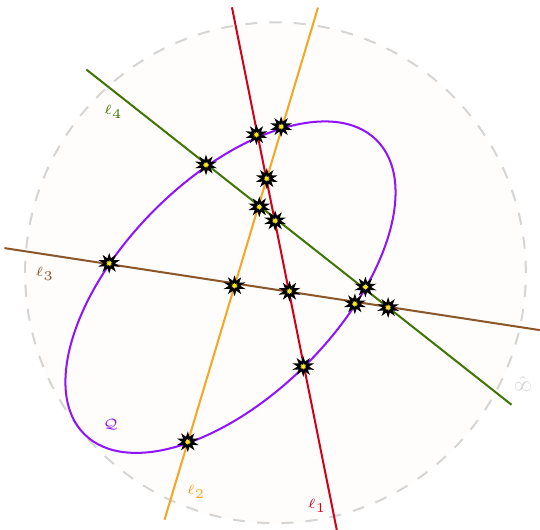
Figure 9 . The configuration space of four lines and a quadric on the projective plane. There are 14 normal crossing points P (labelled by yellow stars). The shaded dashed circle represents the ij line at infinity, which is not in our configuration space. Non-degenerate configurations always seem to come with 11 bounded